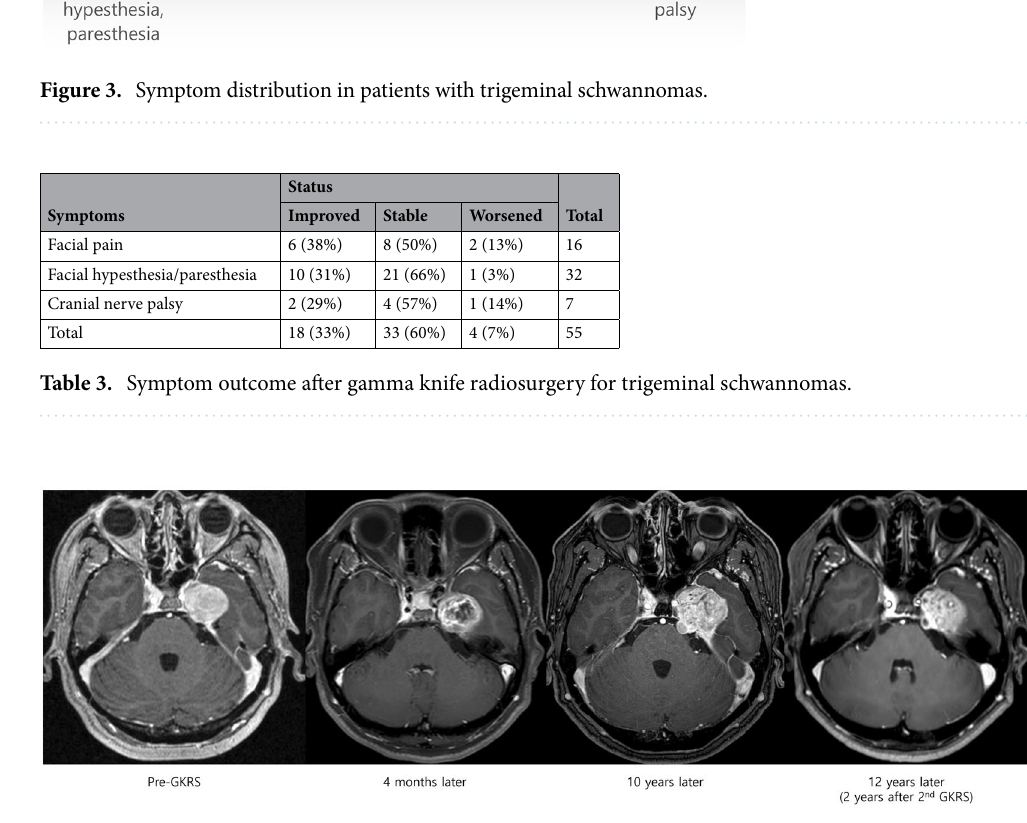
Figure 4. Illustrative case showing tumor size reduction and symptom improvement at 4 months after GKRS (12 Gy, 50% isodose line). The patient experienced facial pain worsening at 10 years after GKRS. Brain